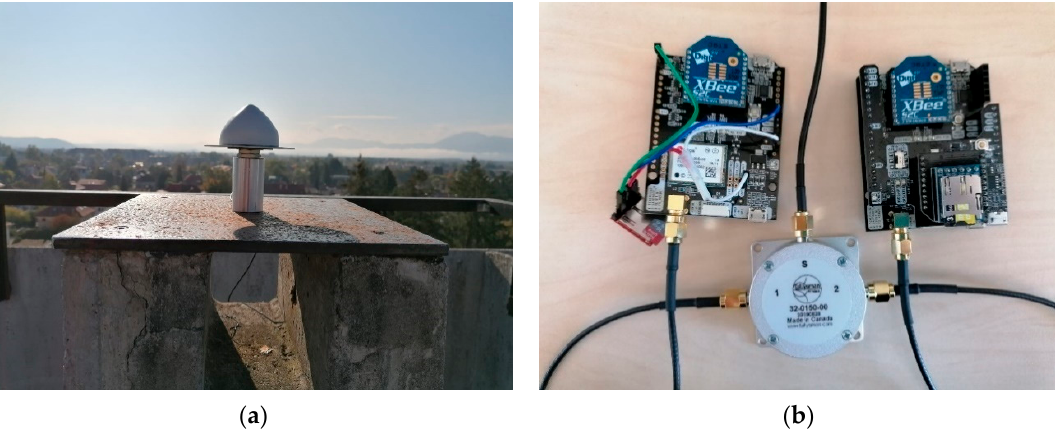
Figure 1. Global Navigation Satellite System (GNSS) instruments used in the zero baseline test: ( a ) Tallysman antenna TW3882; ( b ) Signal splitter TW 150 L and SimpleRTK2B V1 boards.